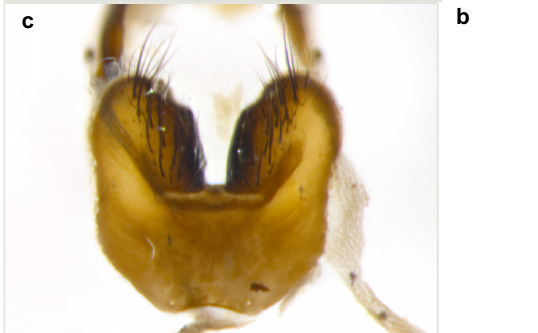
Figure 14. Male terminalia of Calolydella discalis sp. n. ; a–c : paratype, voucher n. DHJPAR0017773 a : lateral view b : dorsal view c : sternite 5 in ventral Female : not known at this time. Diagnosis Calolydella discalis can be distinguished from all other species of Calolydella by the following combination of traits: parafacial mostly gold, fronto-orbital plate with a single row of small black setulae outside of the frontal setae, anatergite with a small tuft of three or more hair-like setae, and T3 and T4 each with two pairs of discal setae. Etymology The specific epithet refers to the two pairs of discal setae on T3 and T4. Distribution